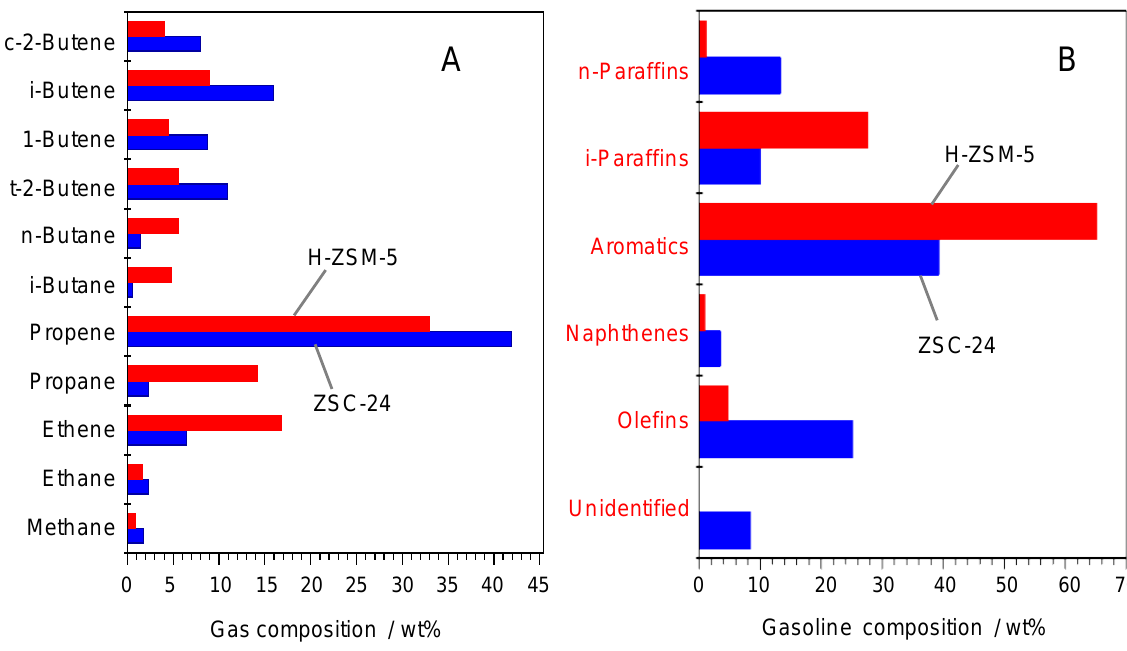
Figure 2. Gaseous hydrocarbon ( A ) and gasoline ( B ) compositions in the catalytic cracking of WCO over ZSC-24 and H-ZSM-5 at 550 °C and a CTO ratio of 0.4 (g∙g −1 ) (wt. % on a product